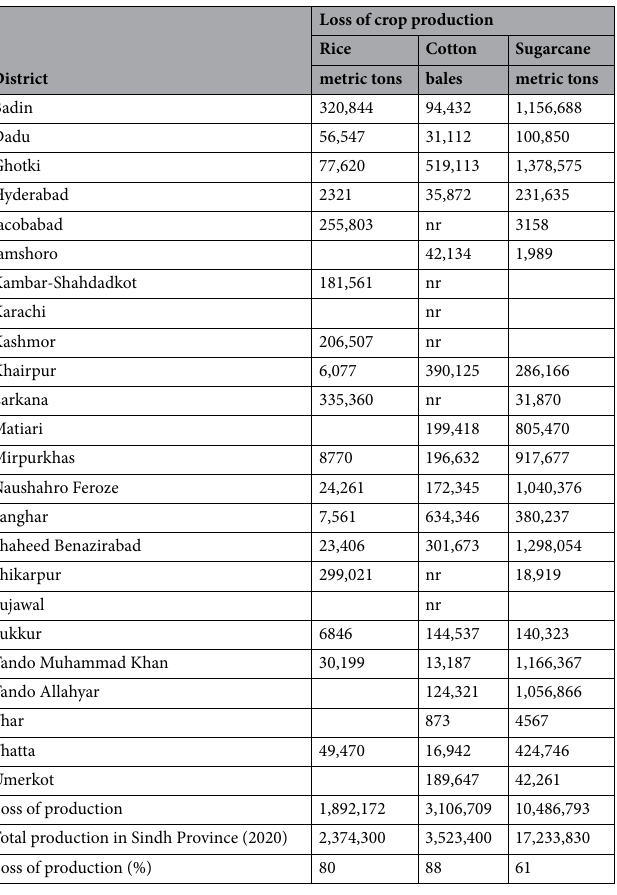
Table 1. Expected production loss of rice, cotton and sugarcane crops in